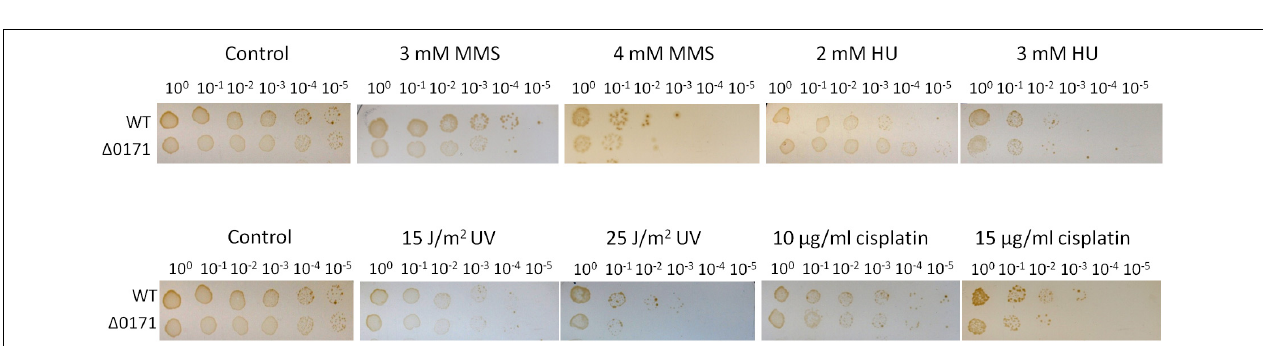
FIGURE 5 | Assay of the sensitivity of the strains to DNA damaging agents. The strains were cultivated until OD 600 ∼ 0.2 and serially diluted by 10 times. An aliquot of 10 µ l for each diluted culture was spotted on the plates and treated with UV (15 and 25 J/m 2 , in B ), or on plates containing methyl methanesulfonate (MMS, 3 and 4 mM, in A ), hydroxyurea (HU, 2 and 3 mM, in A ) or cisplatin (10 and 15 µ g/ml, in B ). The plates were incubated at 75 ◦ C for 7–10 days. The experiments were performed for 2–3 times. Representative figures are shown.